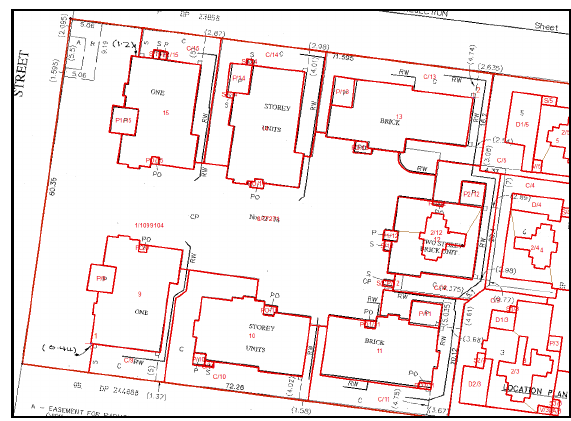
Figure 2: Tracing internal parcels of a georeferenced image